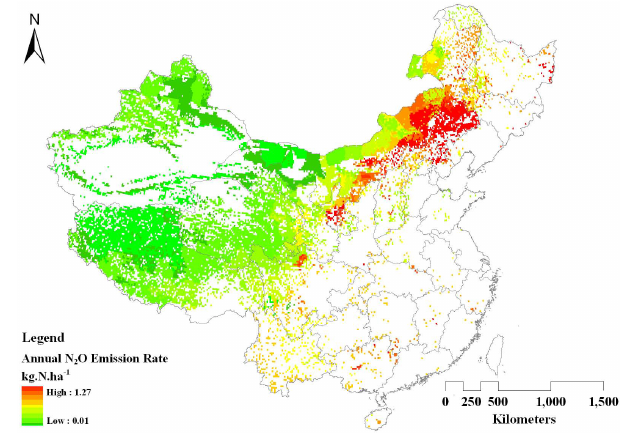
Fig. 4. Three grassland ecological categories of Chinese grasslands. Fig. 5. The spatial distribution of N 2 O flux for Chinese grassland (the blank area is non-grassland).